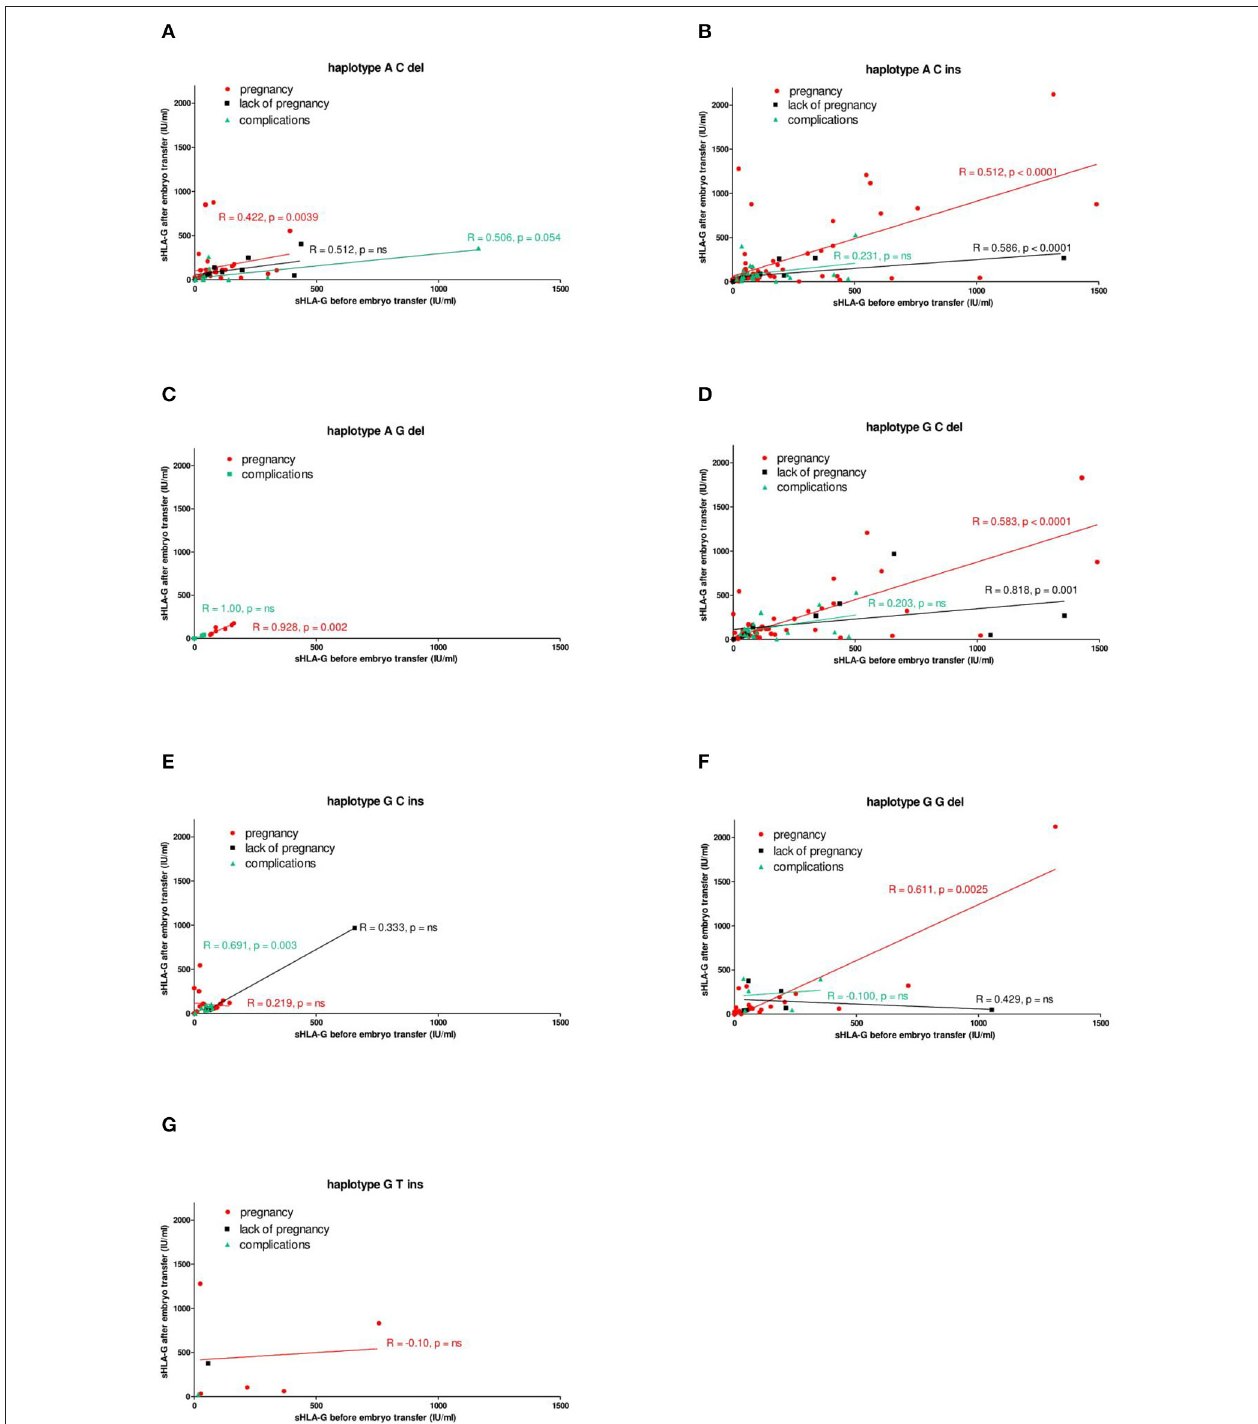
FIGURE 4 | Correlation of soluble HLA-G level with pregnancy outcome, dependent on HLA-G haplotypes. Haplotypes were estimated in all patients in the following order: rs1632947: − 964G > A; rs1233334: − 725G > C/T; rs371194629:insATTTGTTCATGCCT/del and presented as (A) ACdel, (B) ACins, (C) AGdel, (D) GCdel, (E) GCins, (F) GGdel, and (G) GTins. Pregnancy was represented by red lines, lack of pregnancy by black lines, and complications (miscarriage) by green lines. Correlation was obtained with Spearman correlation test ( R , Spearman correlation coefficient; p , p -value). On the x and y axes are values for sHLA-G (IU/ml) before and after embryo